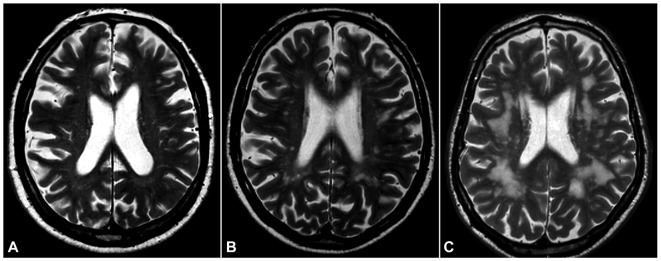
White matter hyperintensities (WMHs). T2-weighted magnetic resonance imaging (MRI) of the brain in three of our subjects, showing three grades of severity according to the Leukoaraiosis And DISability (LADIS) visual scoring scale (modified Fazekas scale): (A), mild; (B), moderate; (C), severe.